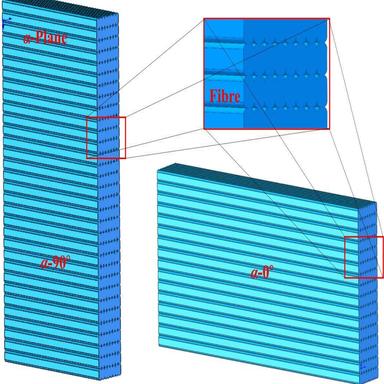
The micro-structure of the plates on α plane.